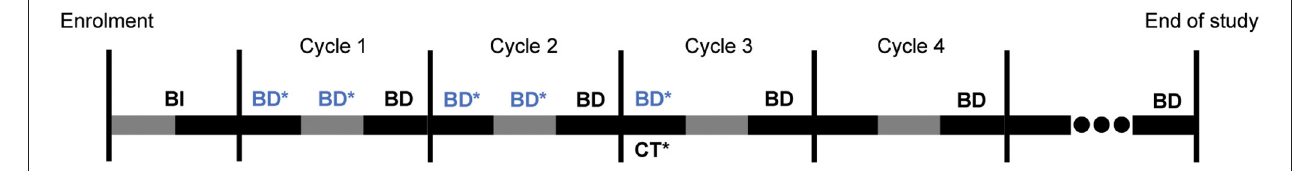
FIGURE 2 | Overall trial schedule for 3 weeks long cycles. BI: Baseline investigations as per standard-of-care, including collection of demographics, medical/treatment history, vital signs, and conducting complete physical examination including performance status evaluation, blood tests [haematology, serum chemistries, tumour marker(s)] and imaging as clinically required. BD: Mandatory blood draws done every 3 weeks for the measurement of tumour marker(s) between Days 17–20 of each cycle, alongside serum chemistries and haematology as per standard-of-care. BD*: Additional blood draws for measurements of tumour markers(s), done once weekly (once between Days 4–7, and another between Days 11–14) performed solely for the purposes of the trial, and are necessary for cycles 1–2 of chemotherapy. Additional blood draws in subsequent cycles will be limited to one draw, if at all. CT*: Computed tomography scans performed approximately every two or three cycles as per standard-of-care. End of study: upon completion of all chemotherapy cycles, or at 12 months, whichever is earlier for each